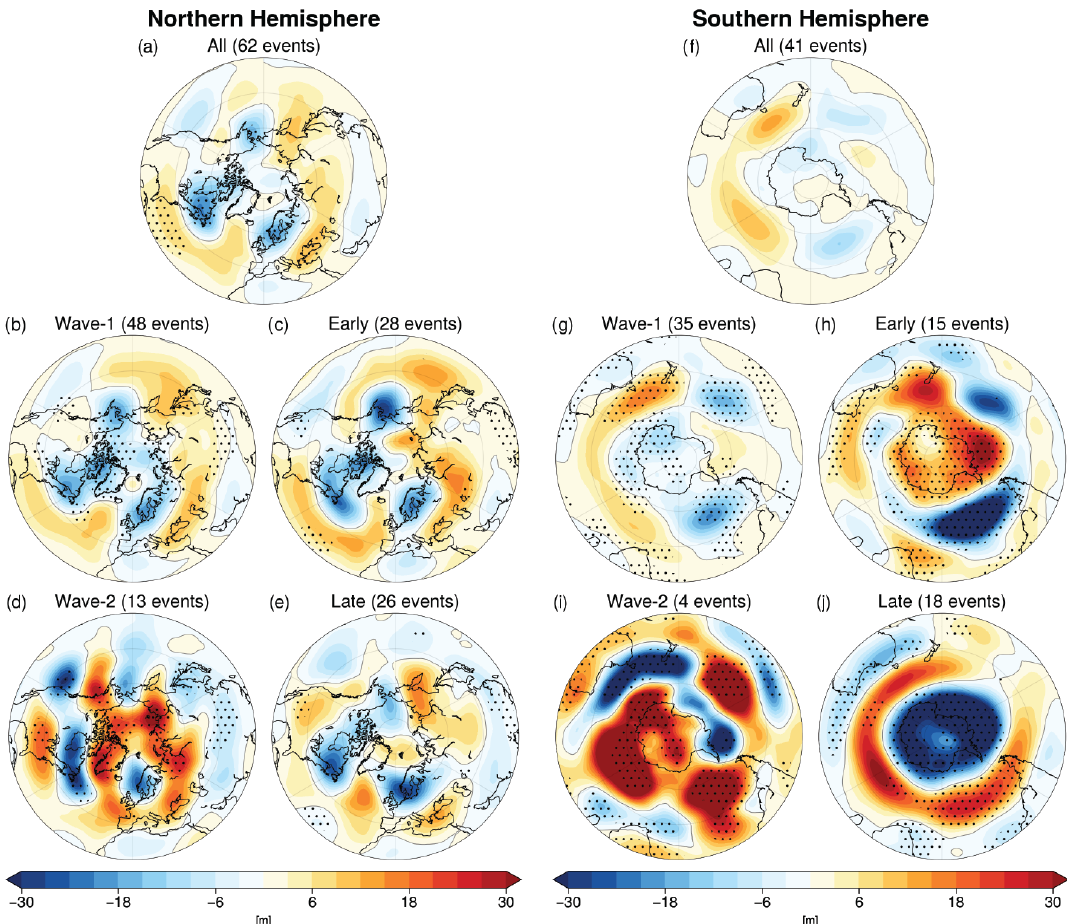
Figure A2. Composite of the linearly detrended 500hPa geopotential height anomalies (m) from JRA-55 data for (a, f) all FSW events based on the 10hPa dates and classified as (b, g) wave-1, (d, i) wave-2, (c, h) early, or (e, j) late averaged over the 7–30d after the central FSW date (i.e., lags of 7–30d) for (a–e) the NH and (f–j) the SH extratropics. Stippling in (a, f) indicates regions where the anomaly composites are significantly different from zero at the 95% confidence level according to a t test, while stippling in other panels shows where composites are significantly different from each other (e.g., wave-1 vs. wave-2, early vs. late) according to a 1000-sample bootstrap analysis (with